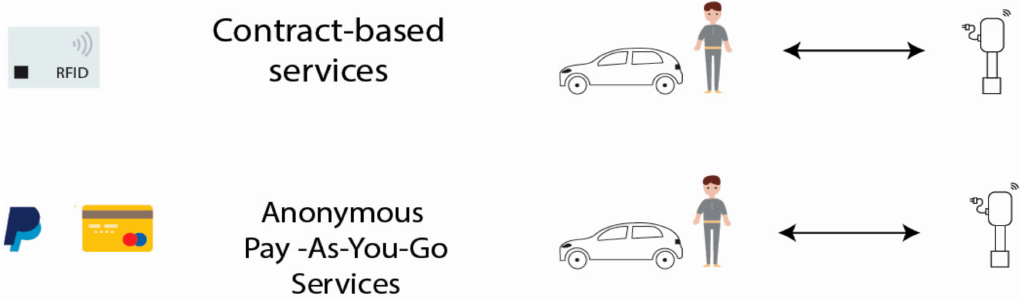
Figure 6. Public charge point payment access options. Adapted from source [31].